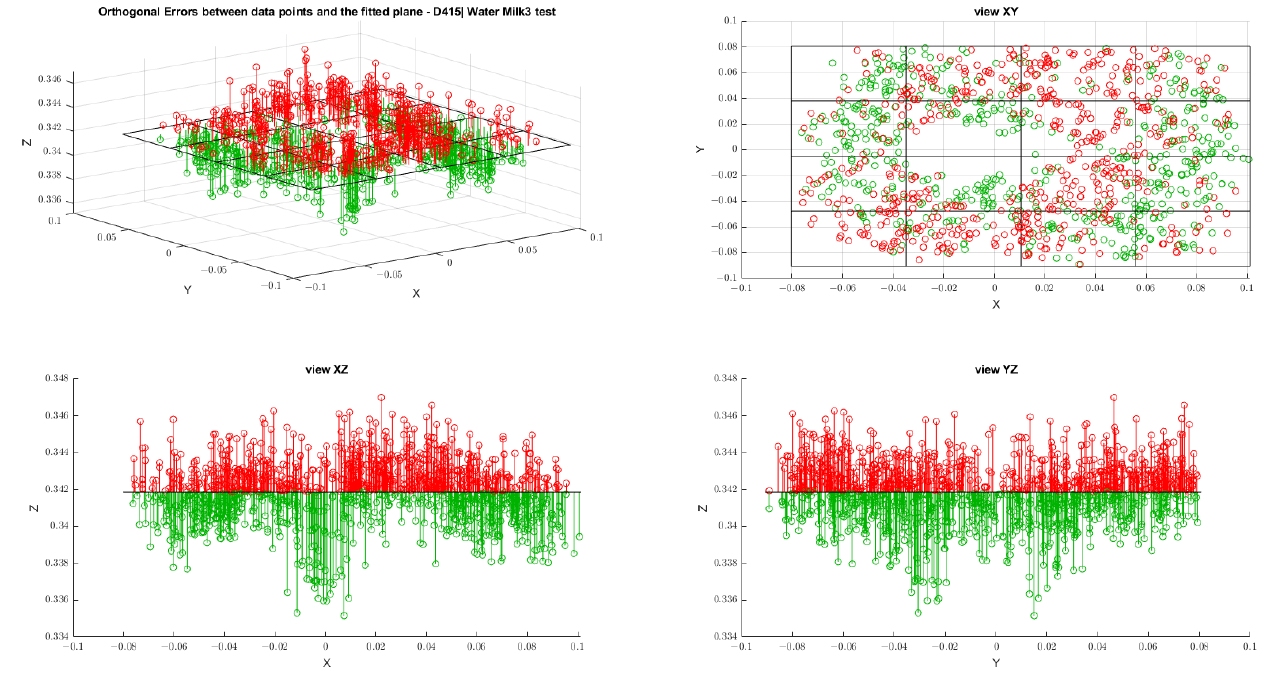
Figure A6. Results of orthogonal errors for the D415 camera referring to the water milk3